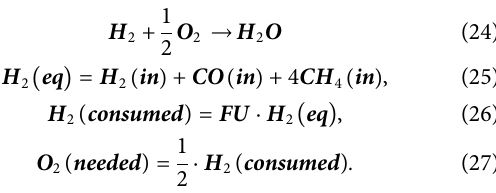
Table S2 ), with an acceptable agreement (with the larger discrepancy in CH 4 composition